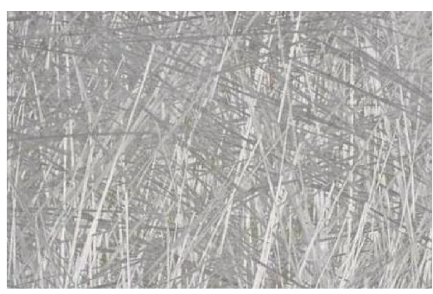
Figure 4: CHM laminated